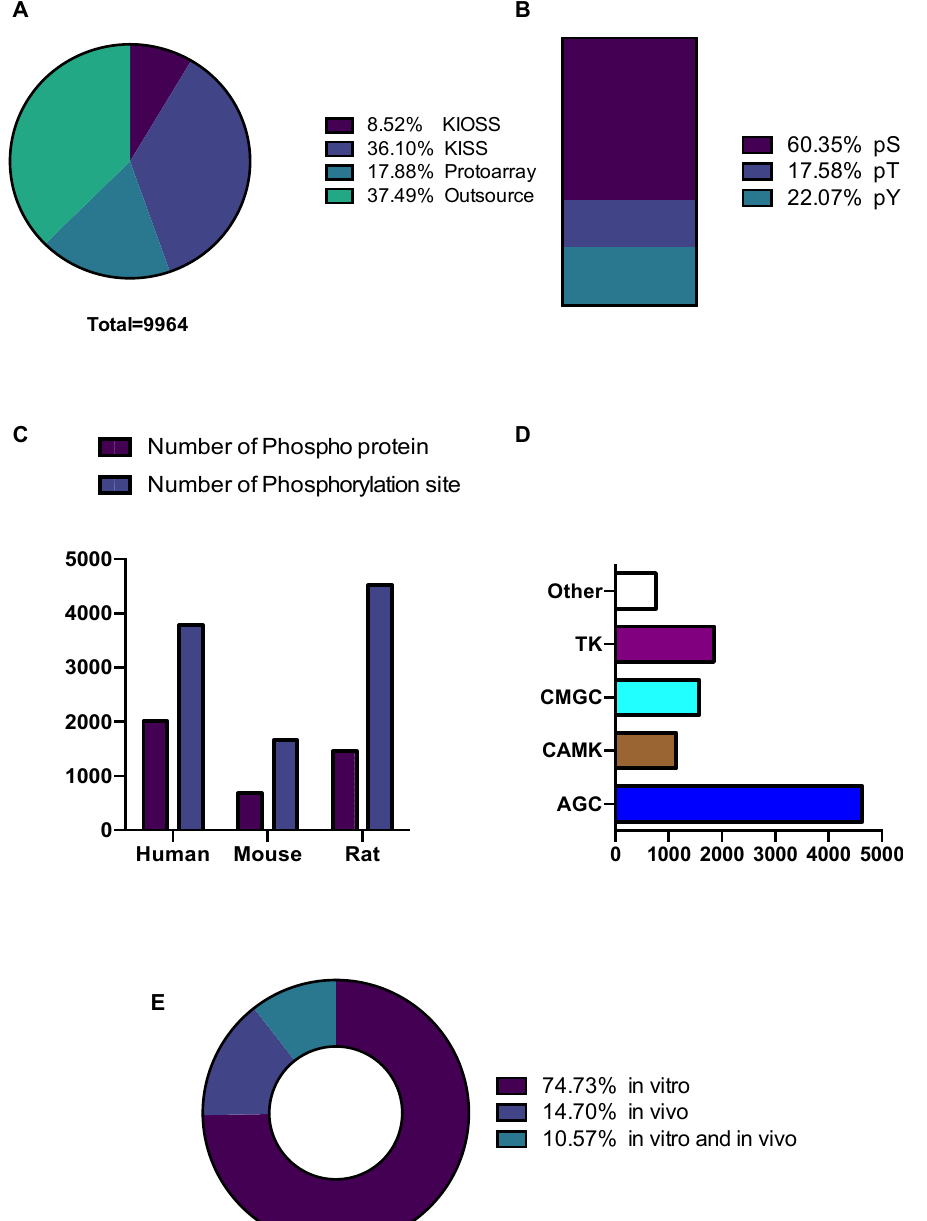
Figure 2. Data statistics and content of KANPHOS database. ( A ) Number of phosphorylation sites that were enlisted in KANPHOS using different methods; ( B ) Percentage of phosphoserine (pS), phosphothreonine (pT), and phosphotyrosine (pY) distribution; ( C ) Number of Phosphoprotein and phosphorylation sites identified in different species; ( D ) Distribution of phosphorylation sites among kinase families; ( E ) Percentage of phosphorylation sites identified in vitro, in vivo, and both in vitro and in vivo.